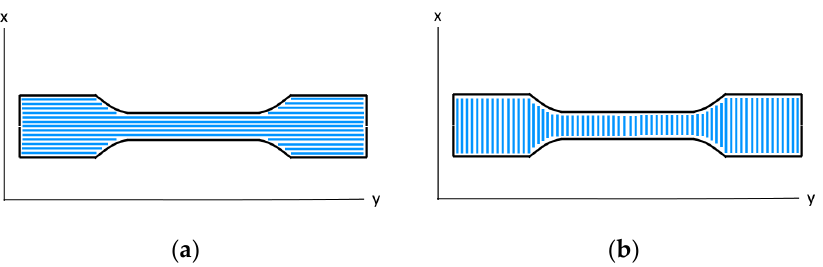
Figure 4. ( a ) Planned printing path for chopped FRP, 0°; ( b ) planned printing path for chopped FRP, 90°.